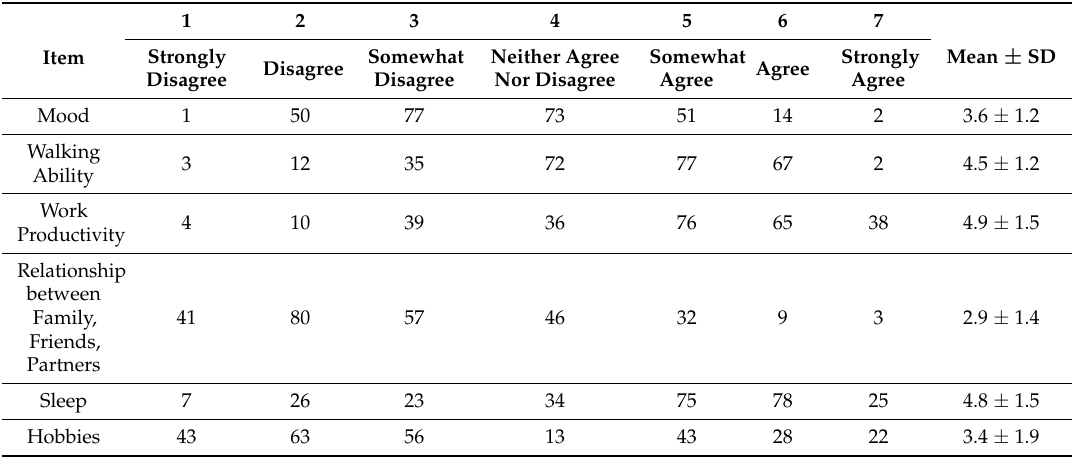
Table 6. Ratings on impacts of pain on workers’ daily living and its percentage in the different categories in the Likert scale (sample size =